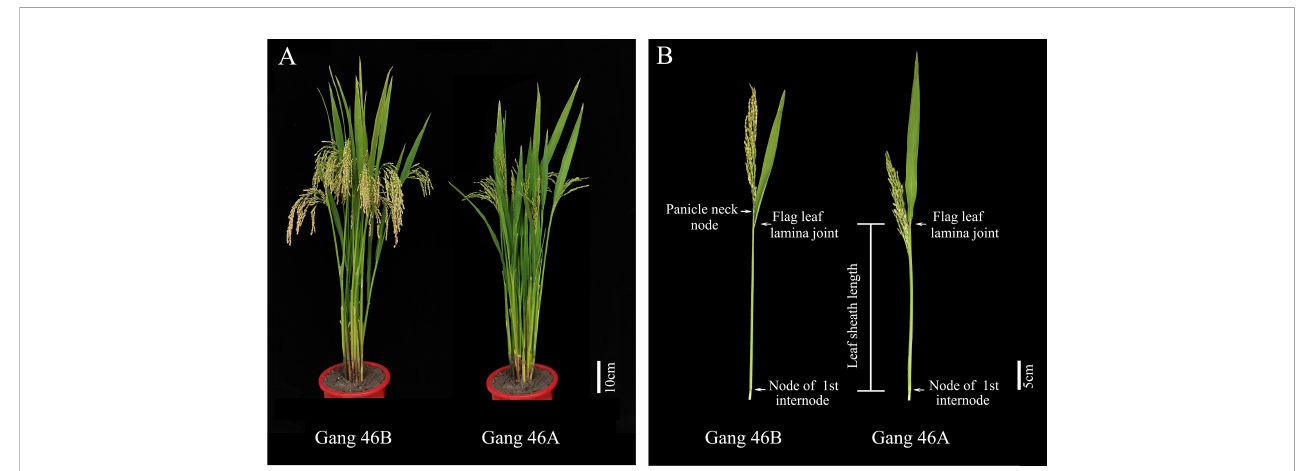
FIGURE 1 Display the plants, panicle, and uppermost internode of Gang 46B and Gang 46A. (A) The plant morphology of Gang 46B and Gang 46A. Scale bar, 10cm. (B) Display the panicle morphology and uppermost internode of Gang 46B and Gang 46A. Scale bar, 5